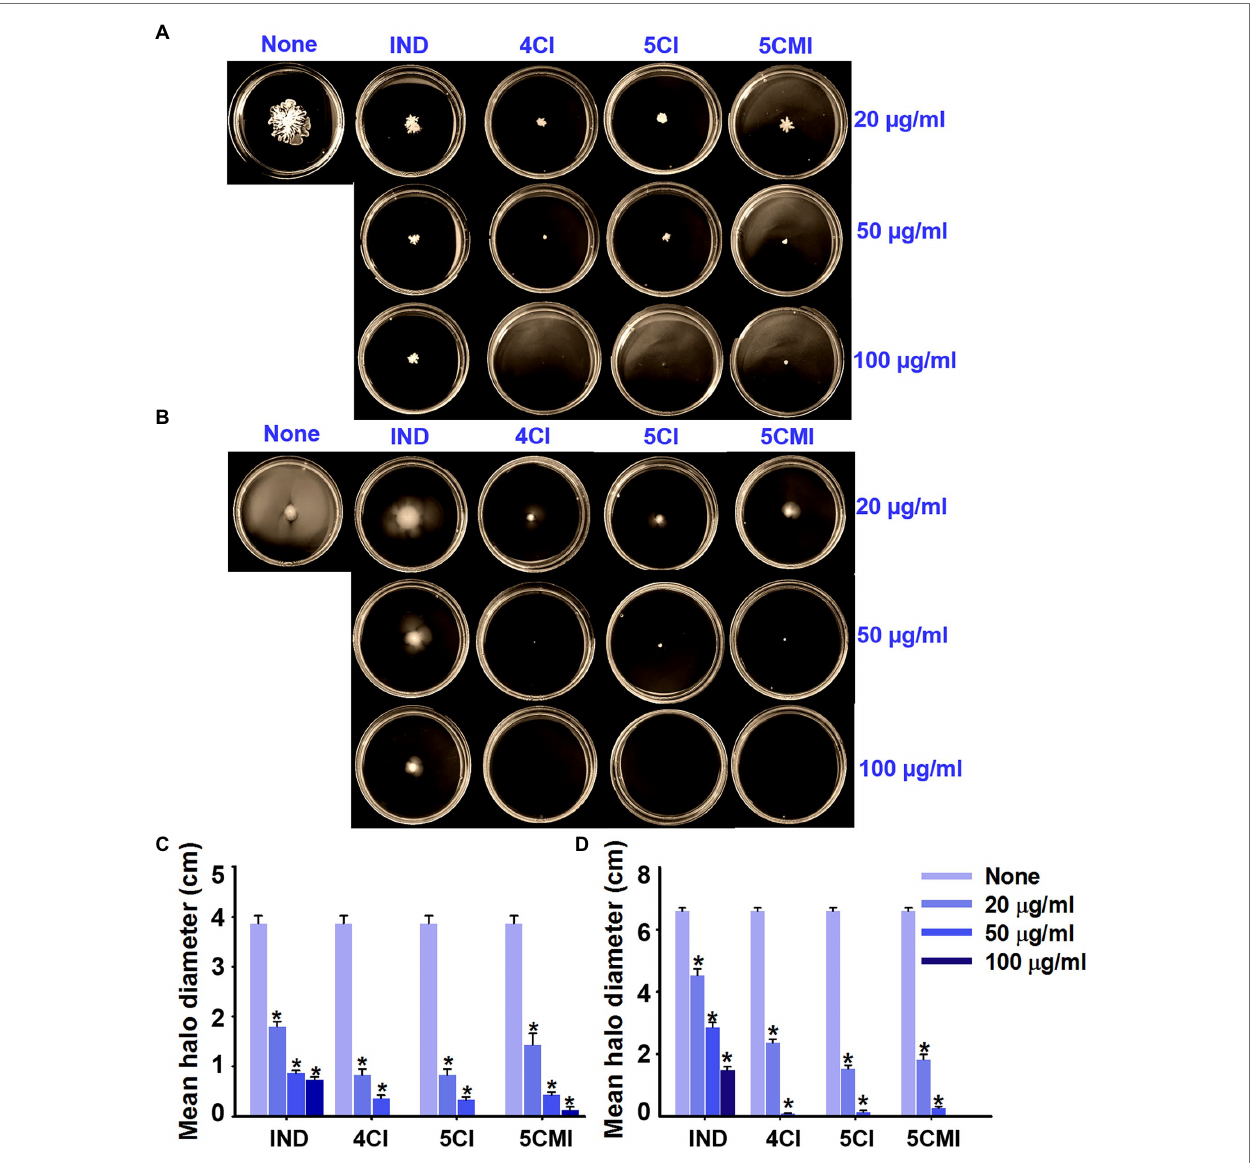
FIGURE 3 | (A) Swarming and (B) swimming motility assay results for UPEC in the presence of indole, 4CI, 5CI, or 5CMI. Mean (C) swarming and (D) swimming motility halo diameters of indole and the three derivatives. * p < 0.05 vs. non-treated